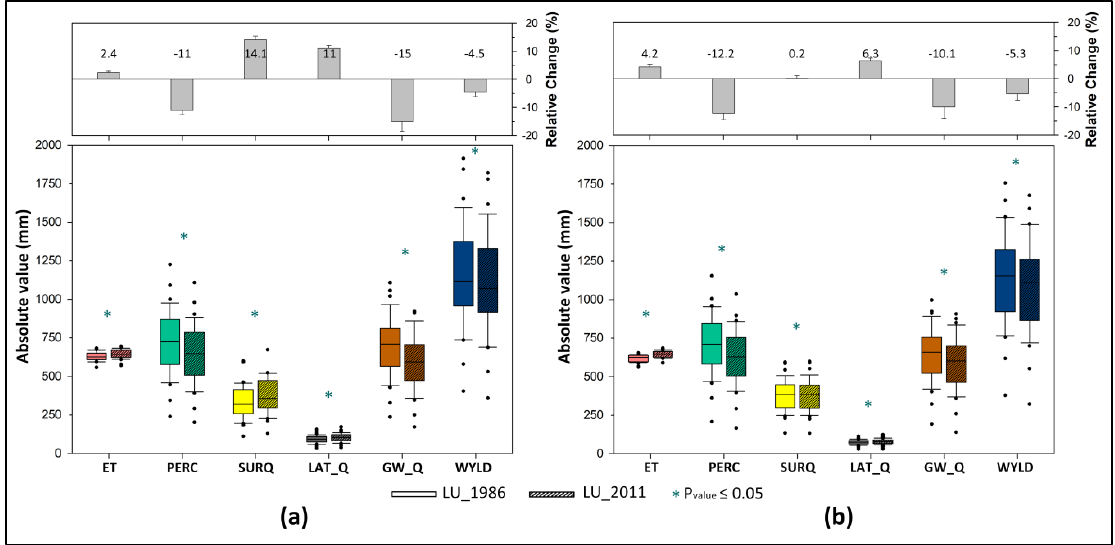
Figure 4. Annual values of hydrological cycle parameters from ( a ) Quino and ( b ) Muco watershed: LU_1986 and LU_2011 scenarios (lower box). Relative changes between LU (upper box).